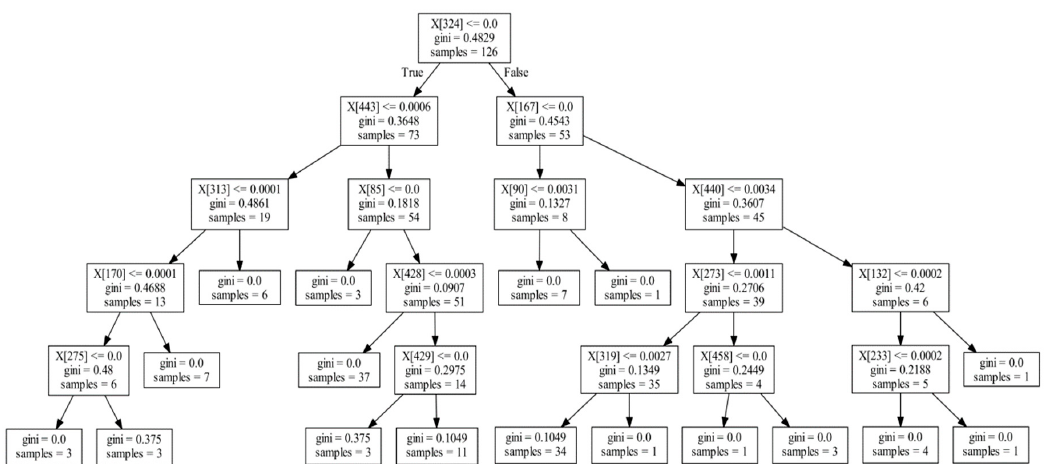
Figure 2. Schematic diagram of one decision tree. Decision trees have nodes and every node includes a feature ID (microbe ID), split value, Gini index, and sample number. a feature ID (microbe ID), split value, Gini index, and sample number.